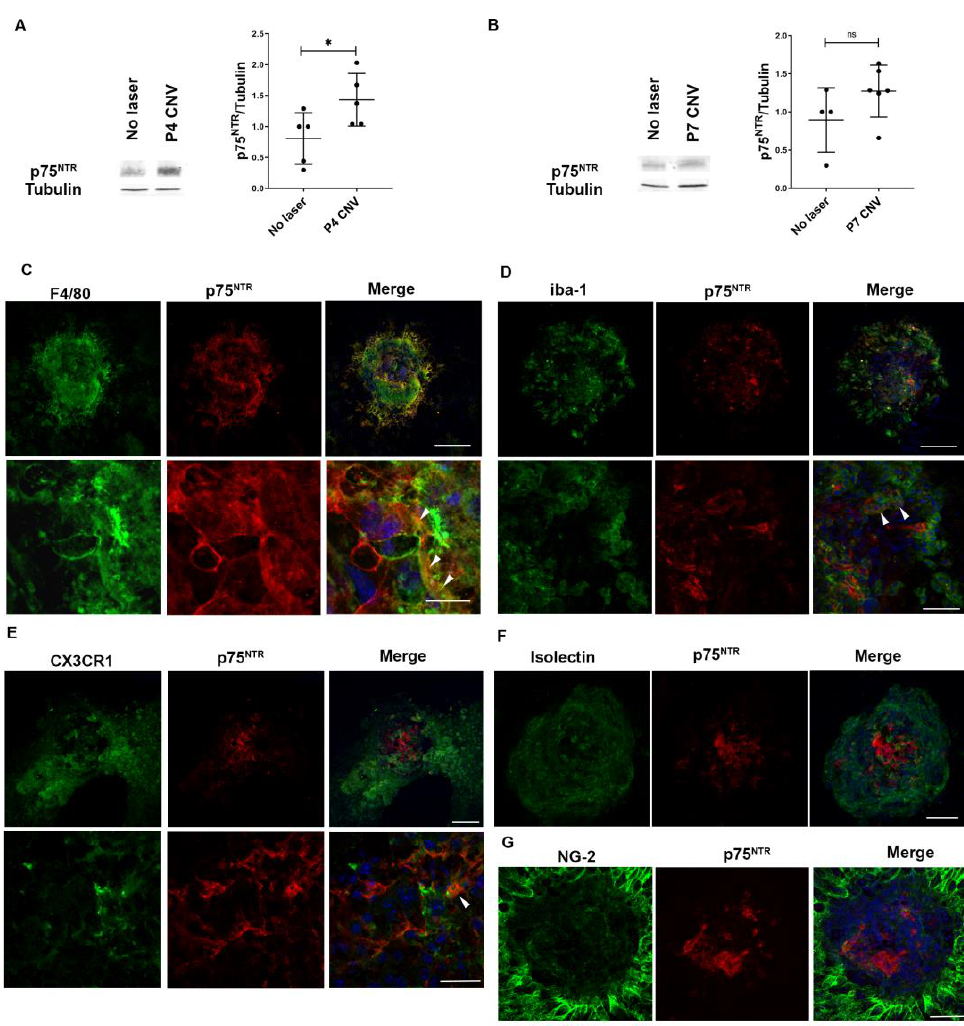
Figure 1. MPCs expressing p75 NTR migrate into the laser-injured area of RPE-Choroid. p75 NTR co-localizes in F4/80 positive cells in RPE-Choroid. Tissue extracts and flat-mounted retinas were prepared and evaluated by Western blot and by IHC. ( A ) Representative Western blot of RPE-Choroid homogenates prepared from WT mice without CNV, or 4 days after laser injury. Tubulin was used as loading control. Bands were quantified by densitometric analysis, and p75 NTR /tubulin ratio is represented in the bar graph expressed as units relative to control. Bars denote the mean ± SD from triplicate experiments, n = 5 mice/group. The asterisks show statistical differences respect to control. * p < 0.05. ( B ) Representative Western blot of RPE-Choroid homogenates prepared from WT mice without CNV, or 7 days after laser injury. Tubulin was used as loading control. Bands were quantified by densitometric analysis, and p75 NTR /tubulin ratio is represented in the bar graph expressed as units relative to control. ns: non-significant. Bars denote the mean ± SD from triplicate experiments, n = at least 4 mice/group. ( C – E ) Representative confocal images of RPE-Choroid flat-mounts of WT mice 4 days after laser injury, showing immunofluorescence staining with: ( C ) F4/80 (green), p75